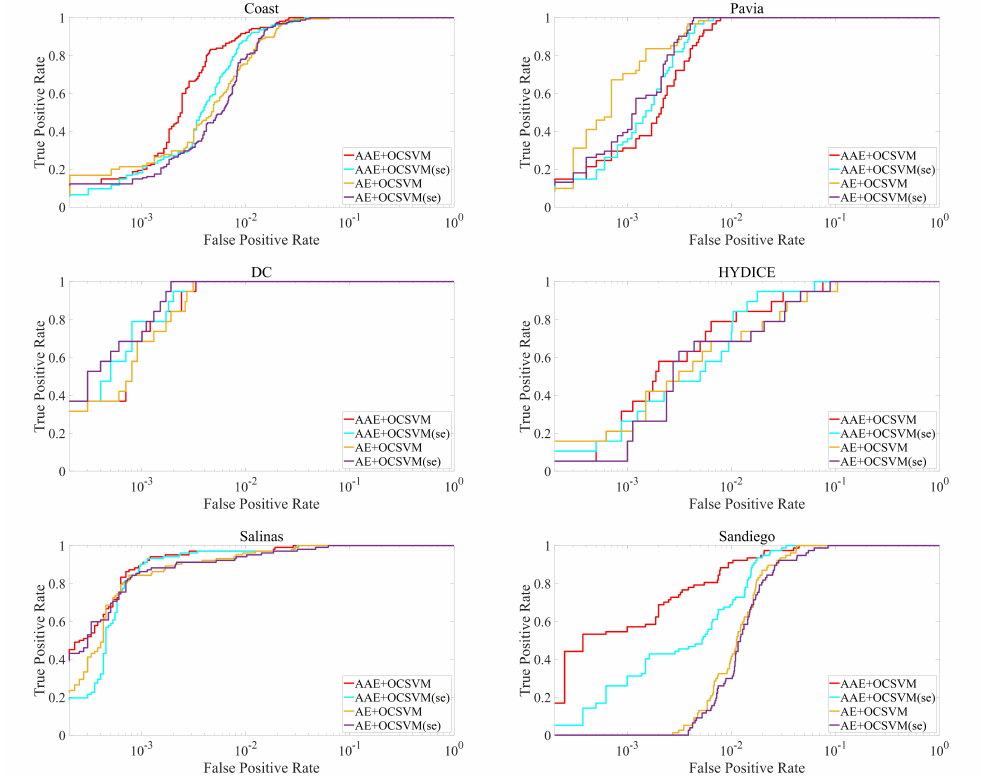
Figure 13. ROC of ( P d , P f ) for training study. Table 7. AUC f of training study. (The maximum is in bold and the second largest is underlined).